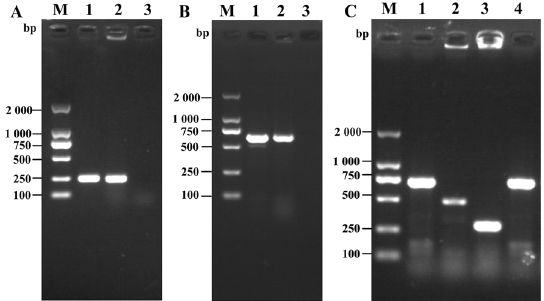
Fig. 3 Isolation and genotyping of Brucella from sheep blood cell lysates. A Identification of Brucella isolates by BCSP31 gene PCR amplification. M, 2,000 bp DNA ladder. Lane 1, B. melitensis M5-90 strain. Lane 2, B. melitensis TZ strain. Lane 3, E. coli ATCC25922